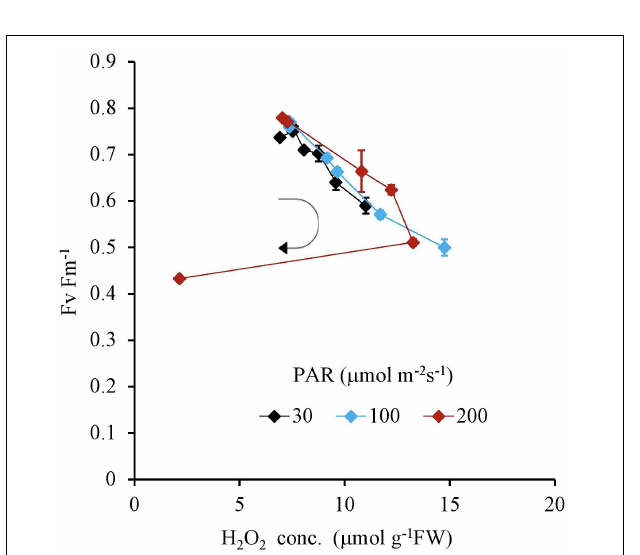
FIGURE 7 | The relation between the H 2 O 2 concentration of plant tissues and SGR after 7 days experiment as a function of Fe concentration in water and PAR intensities. The round arrow indicates the variational trend with increasing Fe concentration. Vertical bars indicate the standard